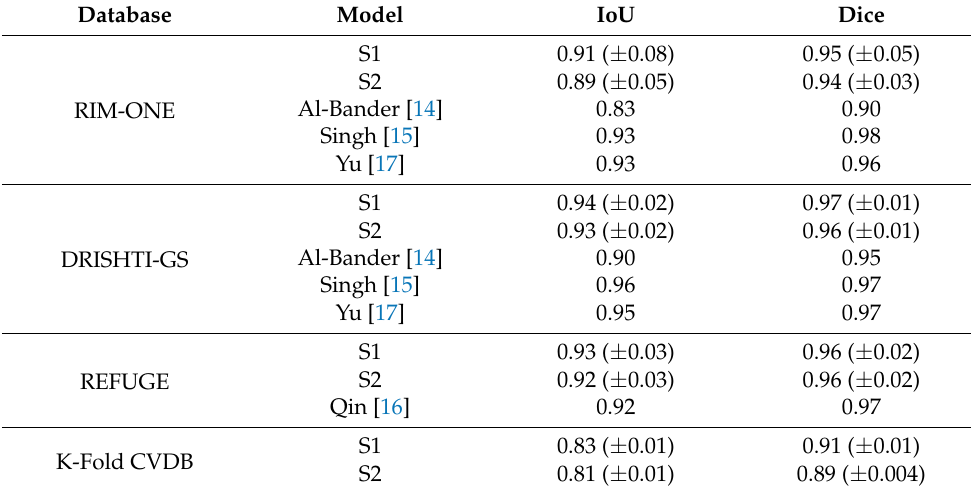
Table 5. Results for OD segmentation for each model and the K-Fold CVDB. For comparison, the results from the literature review are presented as well. S1 is Inception ResNet V2, and S2 is Inception V3.